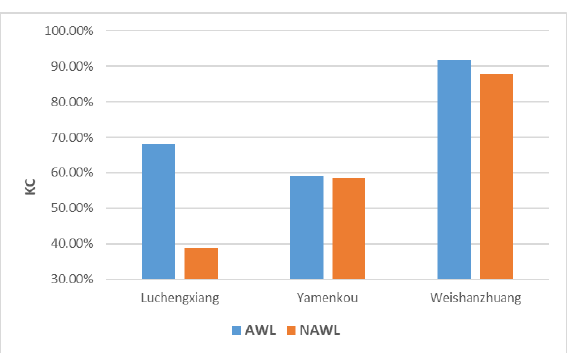
Figure 13. Comparisons of AWL and NAWL on three